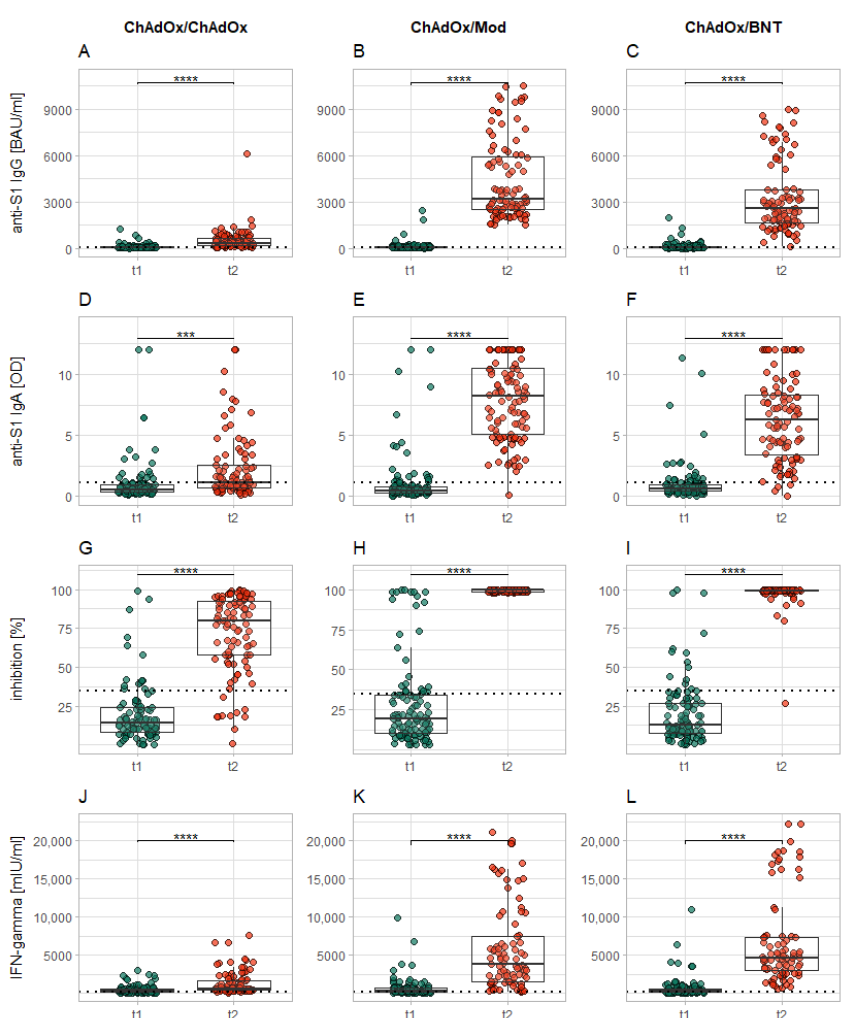
Figure 3. Increase in levels of all examined markers from immediately before the second vaccination (t 1 ) to 14 days after it (t 2 ). Each column of plots represents the reactions to a specific vaccination regimen (ChAdOx/ChAdOx: ( A , D , G , J ); ChAdOx/Mod: ( B , E , H , K ); ChAdOx/BNT: ( C , F , I , L )), while each row represents the different examined markers (anti-S1 IgG: ( A – C ); anti-S1 IgA: ( D – F ); neutralizing antibodies: ( G – I) ; IGRA: ( J – L )). The dotted horizontal lines represent the cutoff for reactivity of the different assays. Levels of significance: * = p < 0.05; ** = p < 0.01; *** = p < 0.001; **** = p < 0.0001.